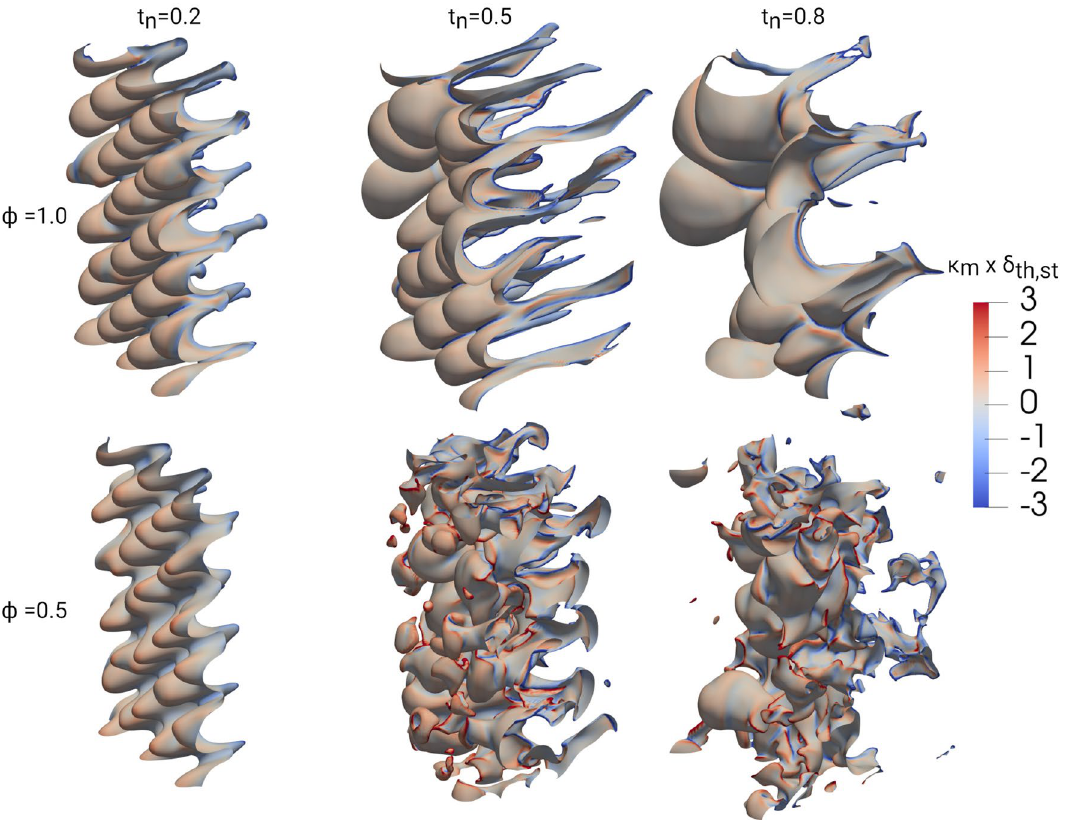
δ th,st , for φ 1.0 (top) and φ = ×